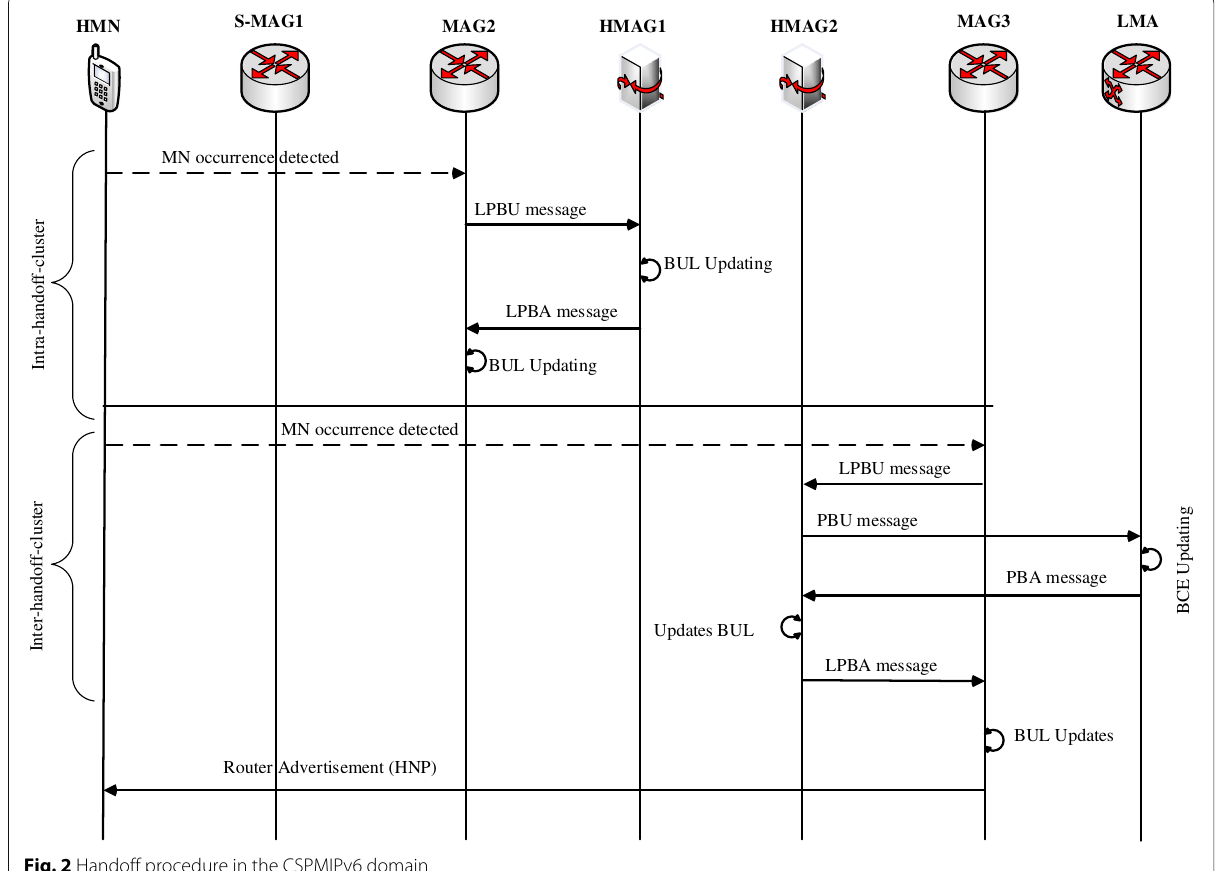
Fig. 2 Handoff procedure in the CSPMIPv6 domain